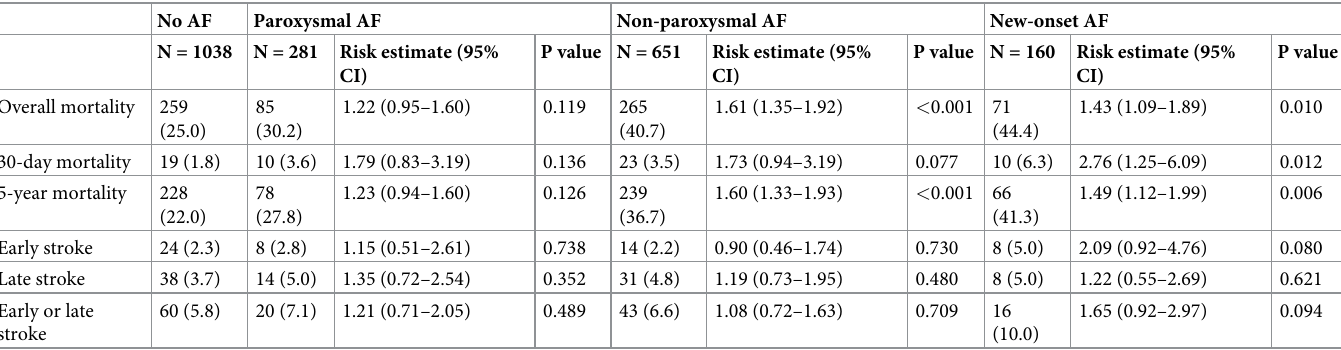
Table 2. Adjusted risk estimates of study outcomes � .